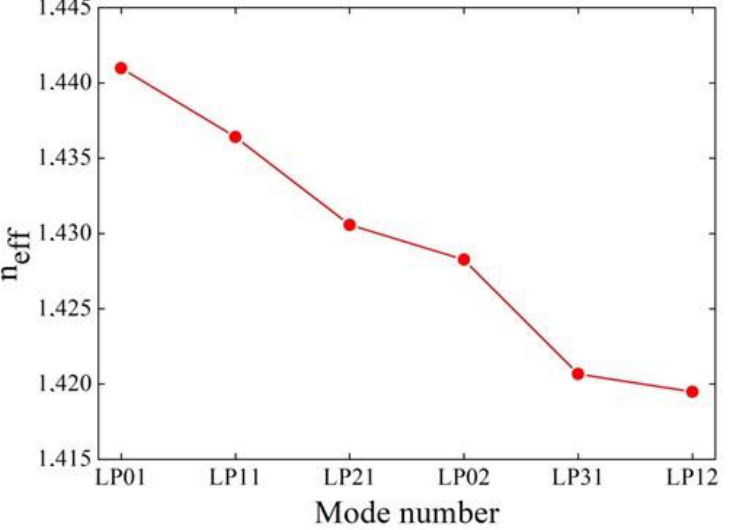
Figure 10. Diagram of distribution of the effective refractive index over guided modes.